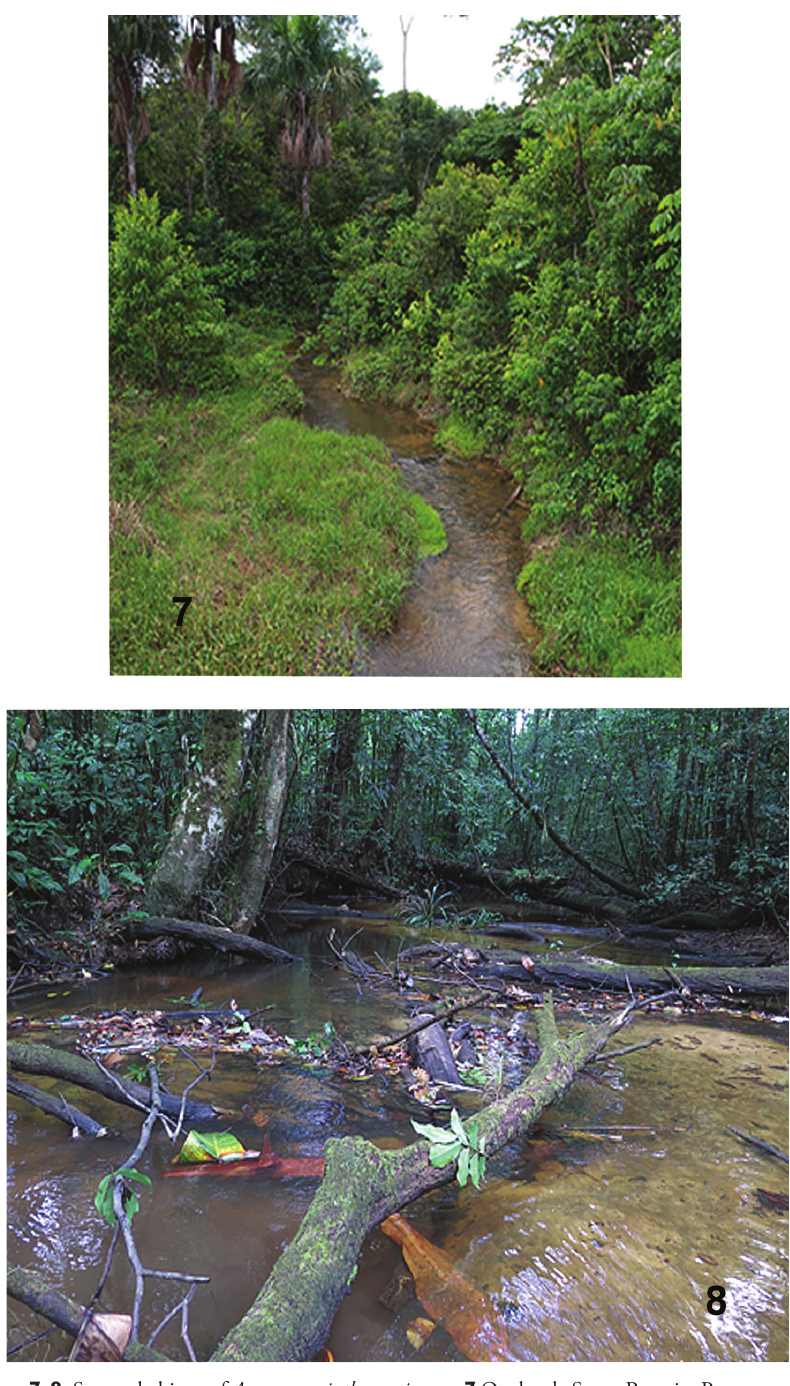
8 Crique Nouvelle France, French